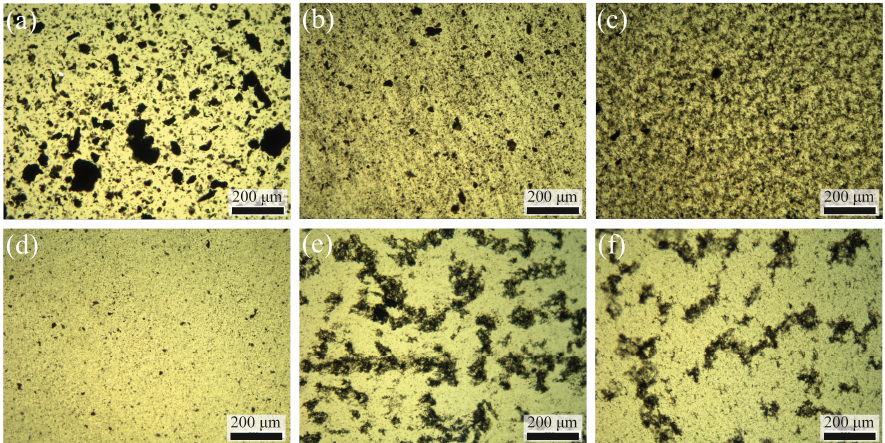
Figure 1. Light micrographs illustrating the dispersion degree of GNP in the epoxy resin ( a ) after mixing the epoxy resin with 0.5 wt % GNP using a high speed mixer, ( b ) and ( c ) after one and three runs of three-roll milling, ( d ) after adding the hardener, and ( e ) and ( f ) after curing at room temperature and at 80 °C, respectively.